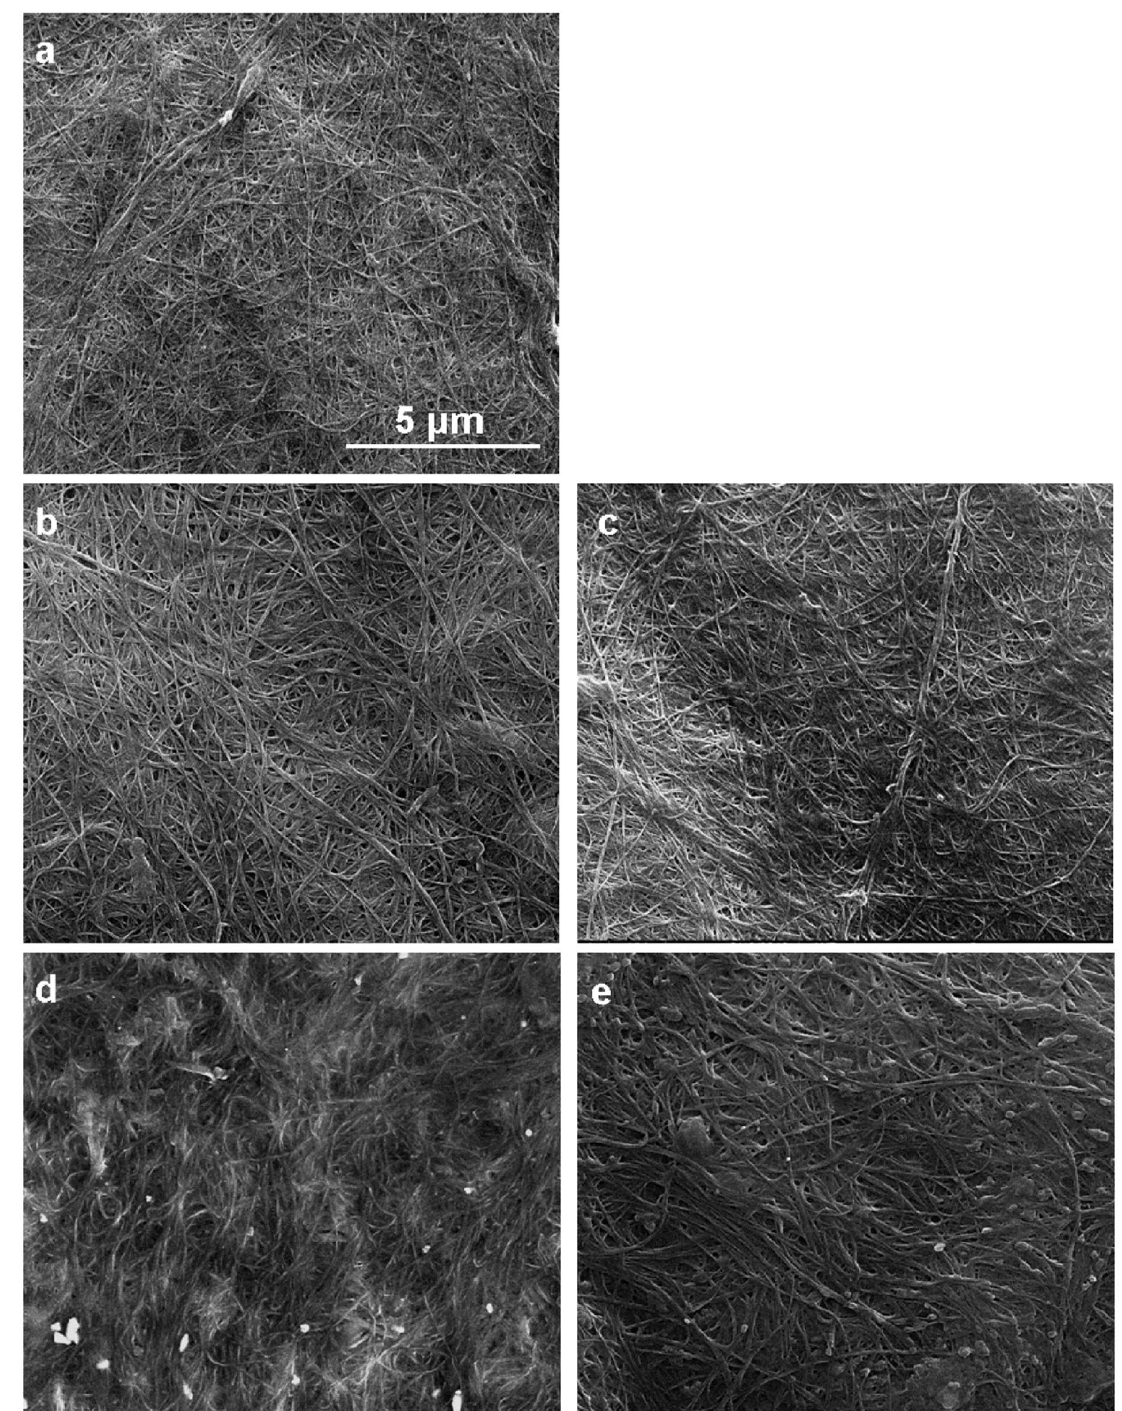
Figure 2. SEM images of BC ( a ), BC-Ac ( b ), BC-AA ( c ), BC-APS ( d ), BC-VS ( e ).